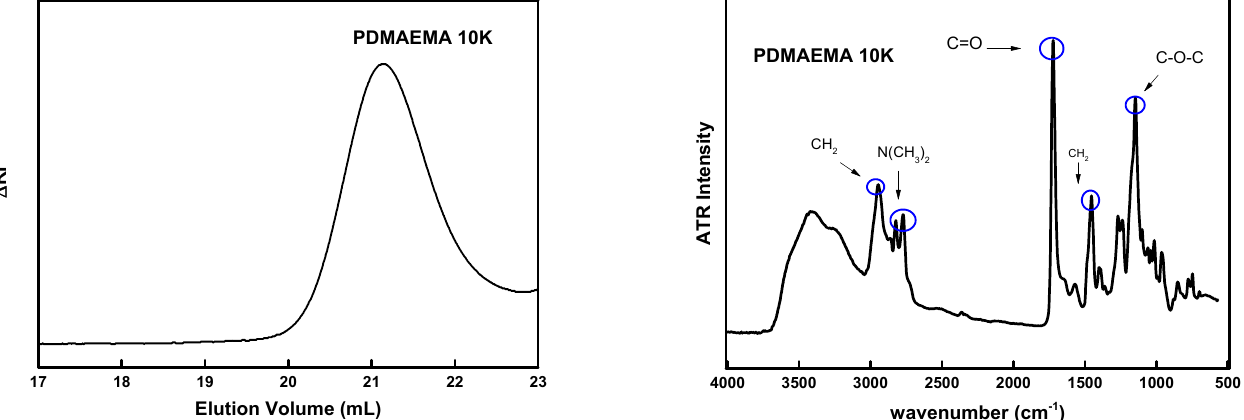
Figure 1. SEC chromatogram ( left ) and ATR-FTIR spectrum ( right ) of the PDMAEMA homopoly- mer precursor .